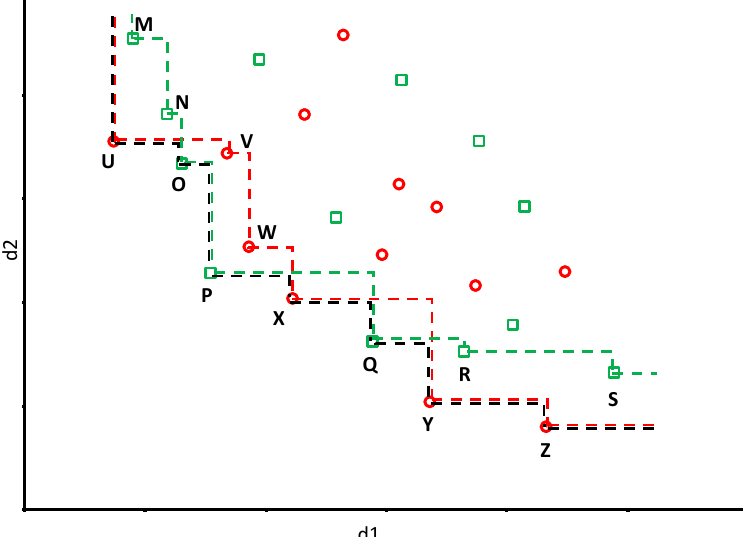
Figure 2. A multi-party skyline Problem. Green Squares and Dotted-Line represent the objects and skyline of DS 1 . Red Bubbles and Dotted-Line represent the objects and skyline of DS 2 . Black Dotted-Line represents the global skyline of DS 1 and DS 2